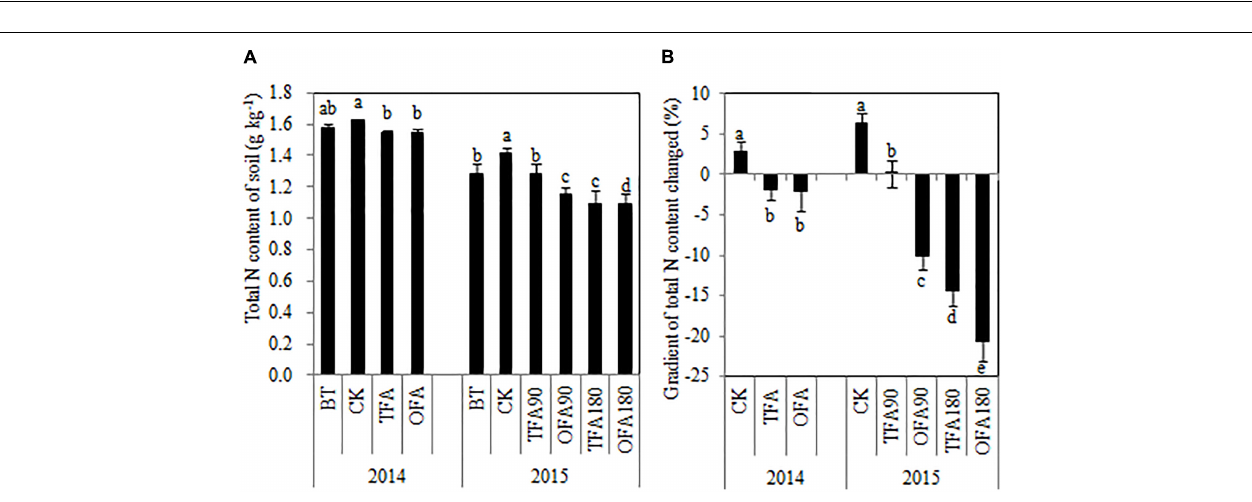
FIGURE 5 | Nitrogen derived from fertilizer and environment (2014, 15 N tracing). TFA: Traditional nitrogen fertilizer application; OFA: optimized nitrogen fertilizer application; Ndff: nitrogen derived from fertilizer; Ndfe: nitrogen derived from the environment; TN: total nitrogen uptake; Data represent mean values of three biological replicates ± SE. “ ∗ ” indicates significant difference between treatments at the 0.05 probability level.